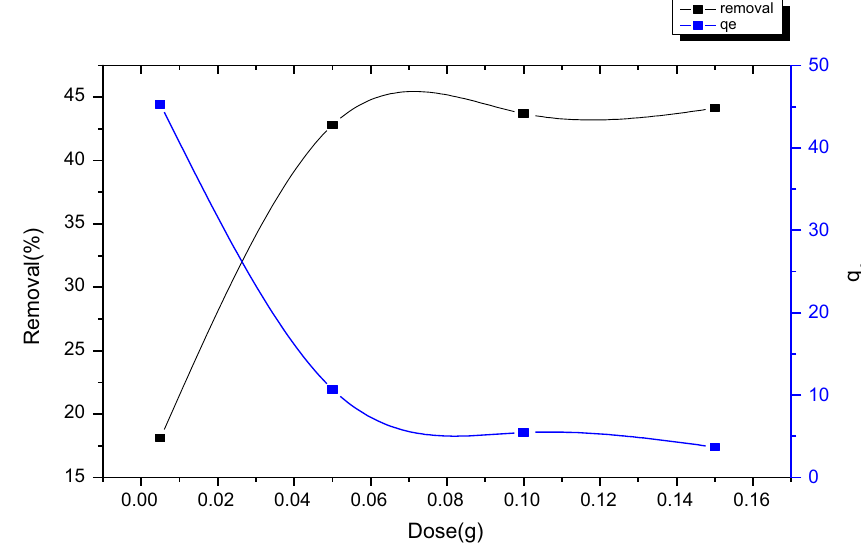
Fig. 6 Effect of absorbents